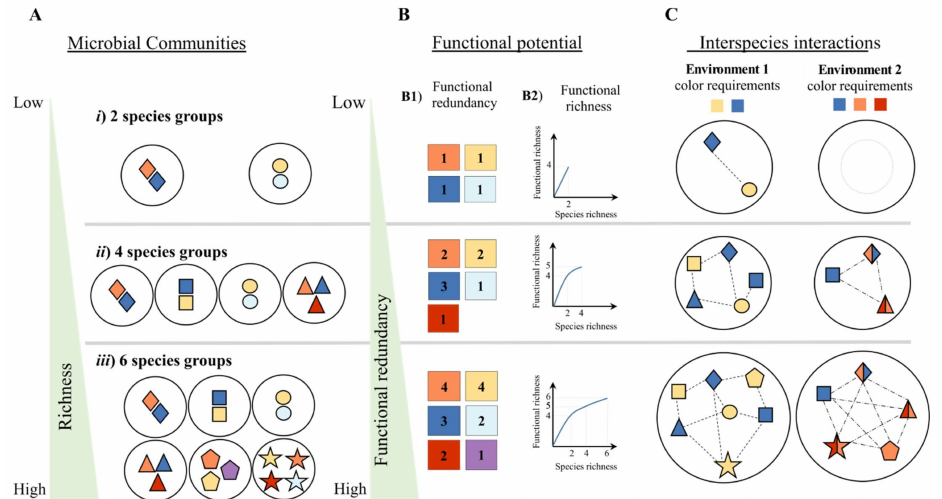
Figure 1. Interplay between microbial community size, functional potential and interspecies interac- tions. Functional richness and redundancy increase with microbial community richness. Three micro- bial communities ( A ) are represented with different levels of species richness ( i , ii and iii ), i.e. different number of unique species (represented by a geometric shape). Each species is capable of performing a number of functions that are represented by a specific color ( B ). For example, community i is composed by two species each capable of performing two different sets of functions. The number of unique functions illustrates the functional richness of each microbial community. Functional redundancy is determined by the number of microbes with the genetic potential to perform the same function. Thus, an increase in the number of unique species is more likely to result in an increase of the functional redundancy ( B1 ) and richness ( B2 ) of a microbial community. For example, from community ii to community iii there is an increase of two species and one unique function but the number of species capable of performing multiple functions (i.e., functional redundancy) also dou- bled for four functions: orange, yellow, blue and red. Furthermore, the combinations of interspecies interactions ( C) is not only dependent on the individual microorganism’s genetic potential but also determined by the environmental conditions. For example, growth in Environment 1 requires a microbe’s ability to perform two functions (blue and yellow) while for Environment 2 three functions are required (orange, blue and red). Although not a linear relationship, the higher the number of species in a microbial community, the higher the probability of an increased number of interspecies interactions (as long as the genetic potential is